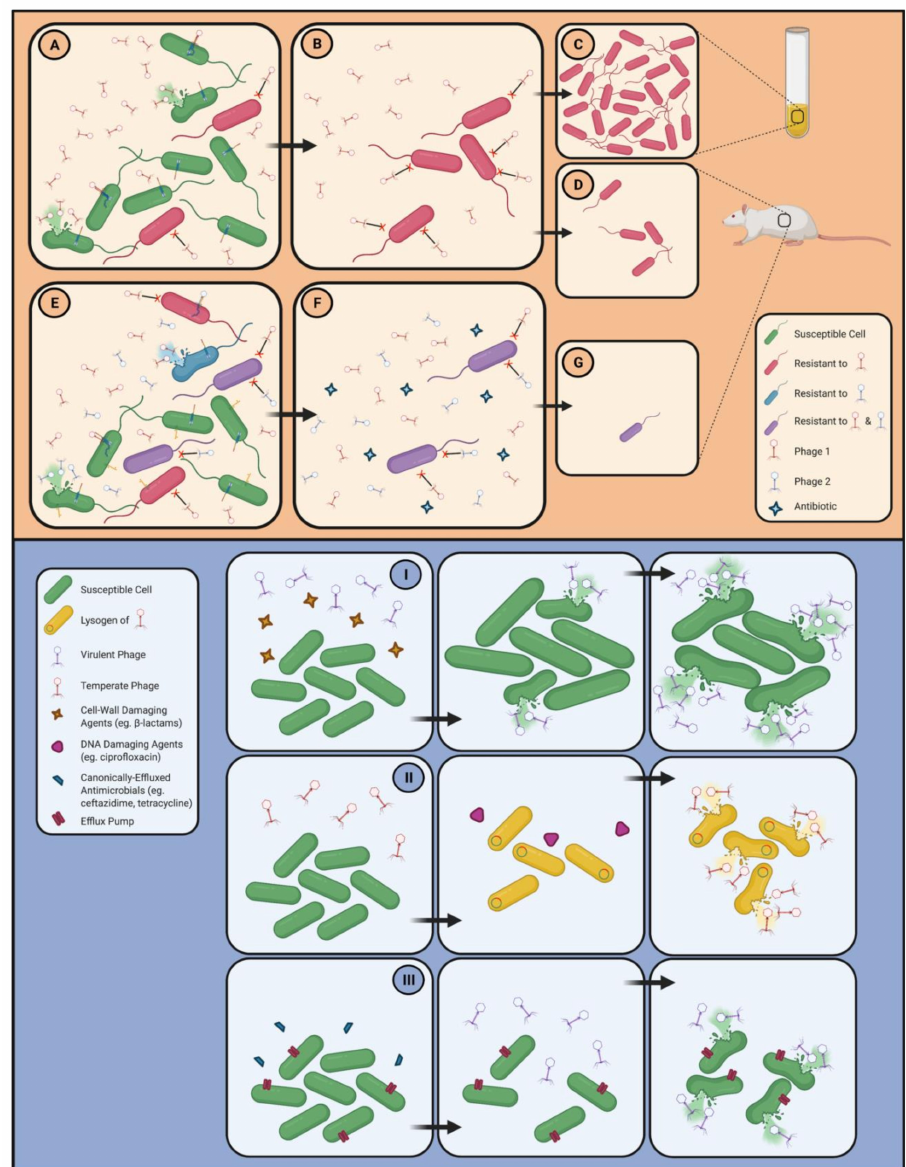
Figure 5. Phage therapy 2.0. Top panel: strategies for the circumvention of problematic phage